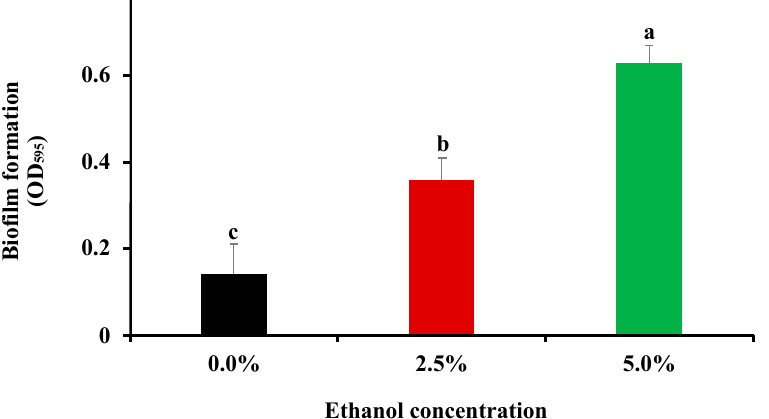
Figure 1. Influence of subinhibitory concentrations of ethanol (1/4 MIC, 2.5%; 1/2 MIC, 5.0%) on biofilm formation of S . Enteritidis. Different letters above vertical bars represent a significant difference ( p < 0.05).